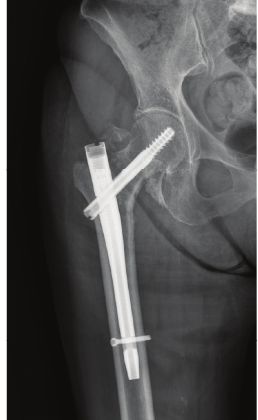
Figure 1: Immediate postoperative AP view radiograph of the right hip demonstrating good position of the anterograde intramedullary nail.